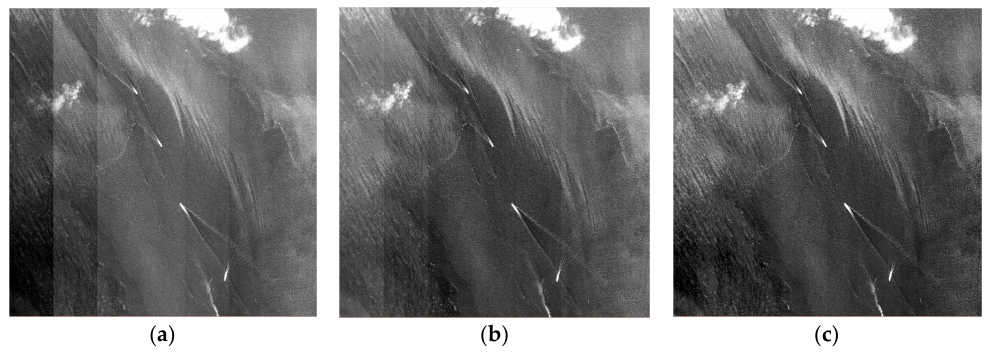
Figure 10. The raw and corrected images of the water. ( a ) Raw image; ( b ) Image corrected using the on-orbit coefficients; ( c ) Image corrected using the side-slither coefficients. Remote Sens. 2018 , 10 , x FOR PEER REVIEW